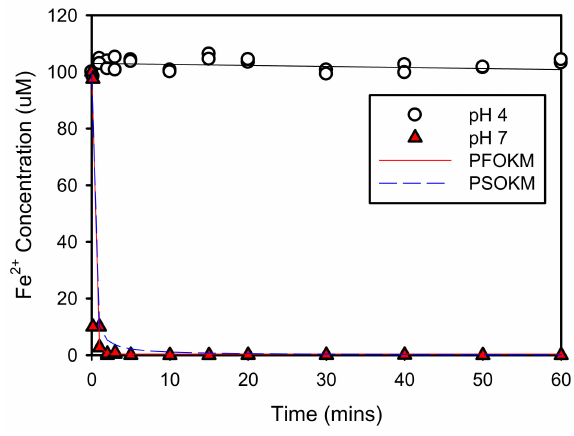
Figure 6. Fe 2 + adsorption onto goethite at pH 4 and